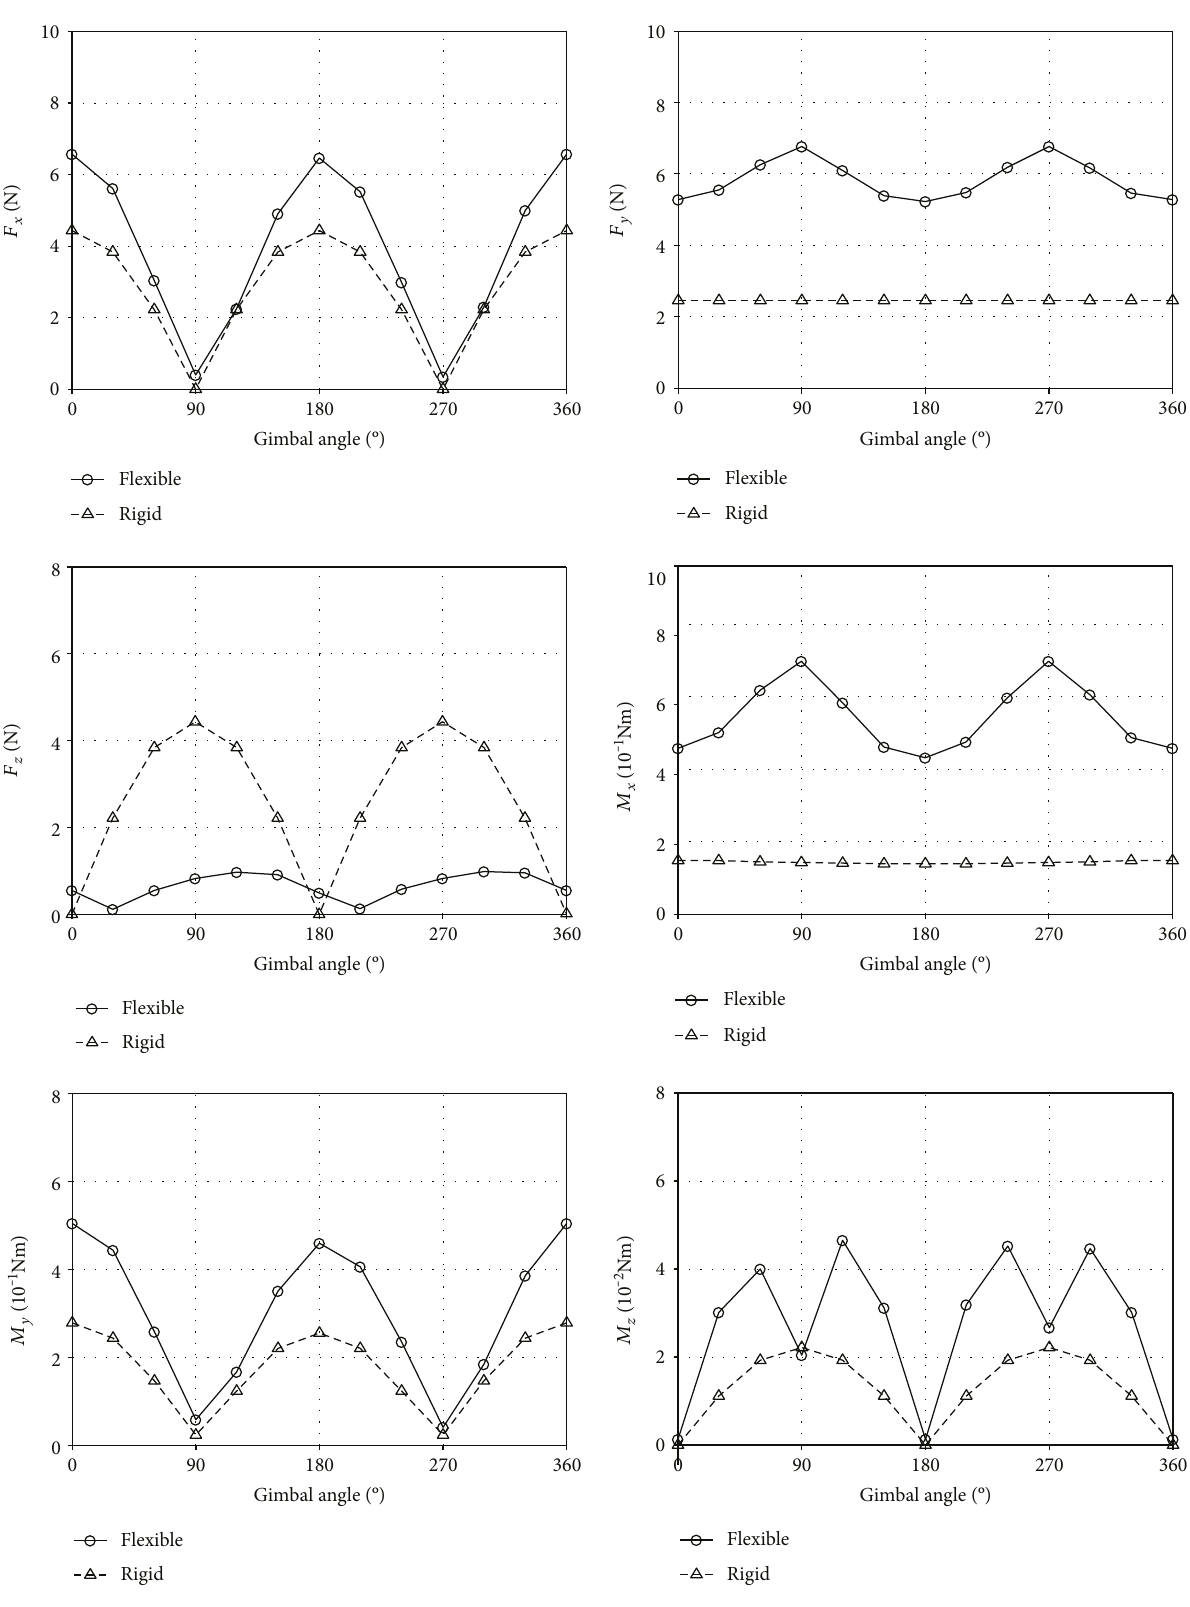
Figure 15: Force and moment amplitude on both the fl exible interface and rigid